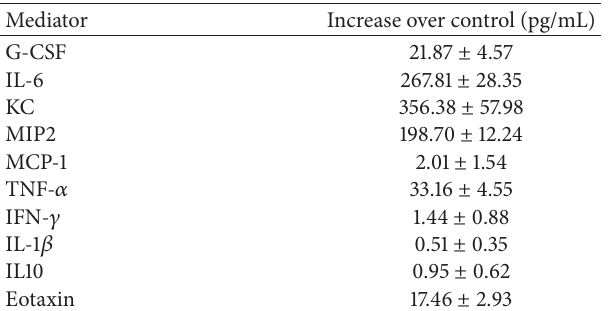
Table 1: Cytokine concentration in lung perfusate samples collected from animals sustaining ventilator-induced inflammation at the completion of 2 hours of mechanical ventilation using the isolated perfused mouse lung model. New uncirculated perfusate was used as the blank control for the ELISA. Values represent mean ± SEM.